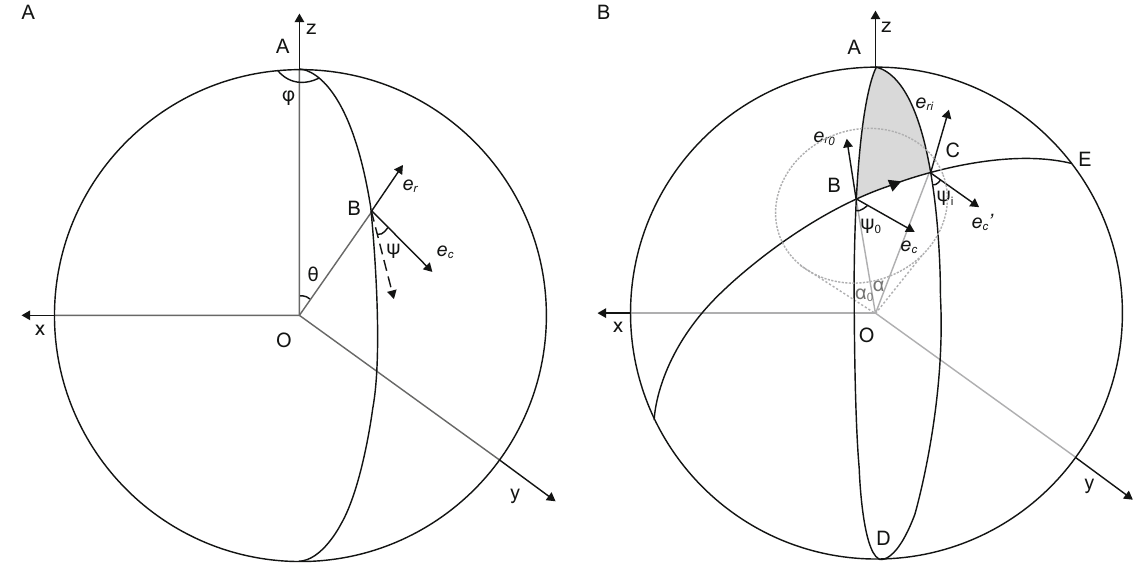
Figure 2. Coordinate system used for searching the optimized orientation of the target module. (A) De fi nition of the position and orientation of a moving camera in the coordinate system with the object fi xed at the origin. The camera plane is assumed perpendicular to the projection direction (OB). Therefore, the position of the camera can be de fi ned by the angle pair ( φ , θ ) or the spherical unit vector e r, and its relative in-plane rotation can be de fi ned by the angle ψ between the camera and the meridian (AB). (B) With the preliminary projection direction of OB, the search range of the camera direction is de fi ned by a cone with the semi-angle α 0 around the preliminary direction OB. When the position of the camera changes from B to C, the direct way for the camera is along the great arc BC by keeping its angle with the arc unchanged (parallel condition) during move. The difference between the relative in-plane rotation angles ψ 0 and ψ i is equal to the difference between the angles of ∠ DCE and ∠ DBE.